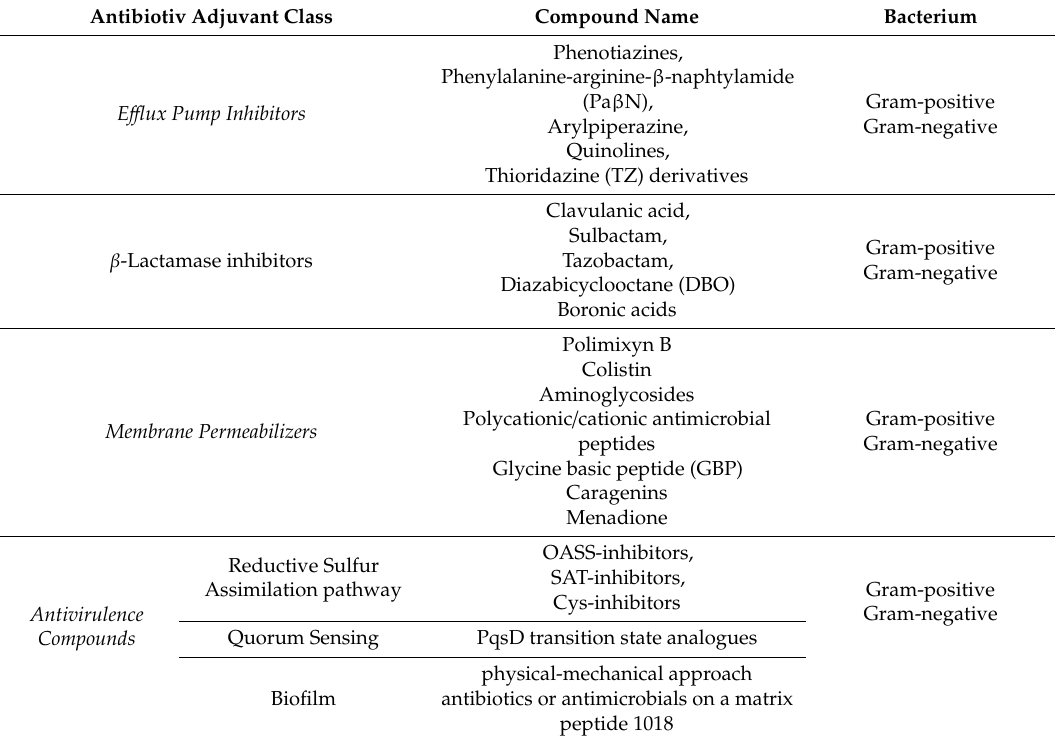
Table 1. Antibiotic adjuvants classes and their inhibitors reported in this